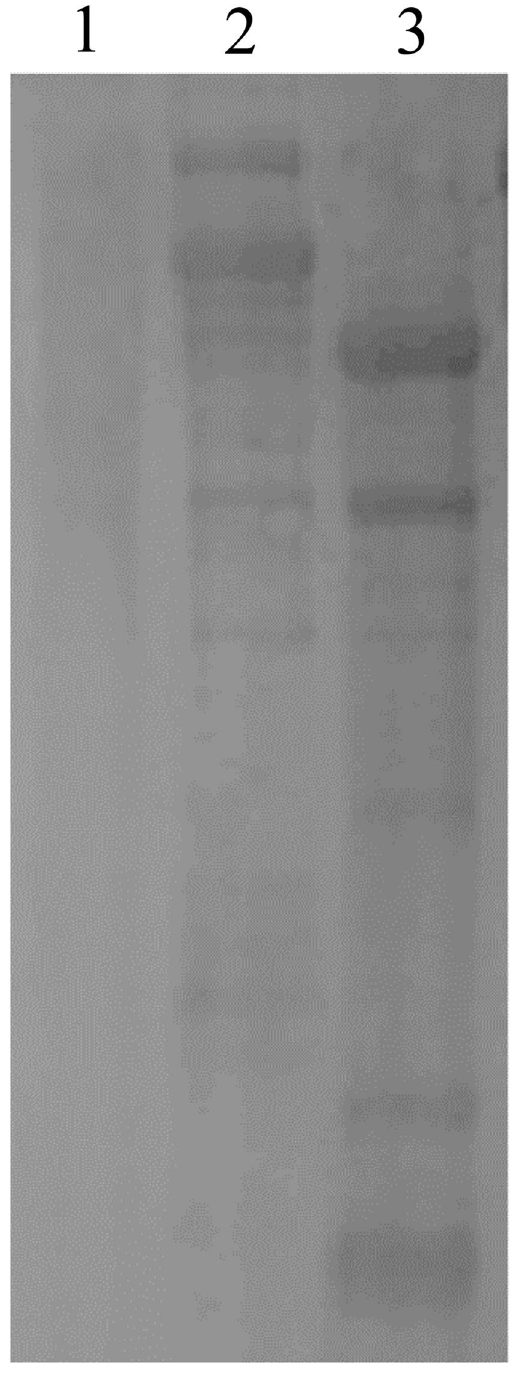
Figure 6. Western blot analysis of WBH from male (lane 1), E 2 -exposed male guppy (lane 2), and purified Lv (lane 3) using anti-Lv antiserum as primary